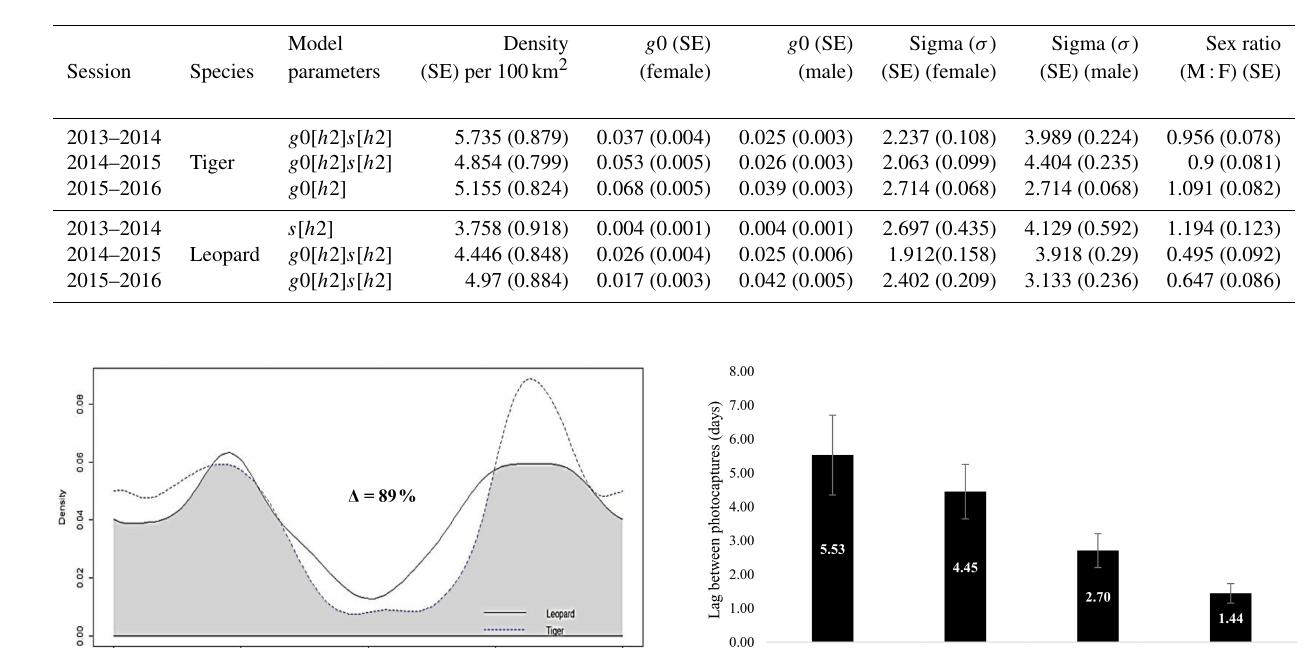
Table 1. Estimated density per 100km 2 along with sex-specific detection probability ( g 0), sex-specific spatial scale of detection ( σ , in km), and detection corrected sex ratio (male:female) of tigers and leopards in Pench Tiger Reserve, Madhya Pradesh, during the study period